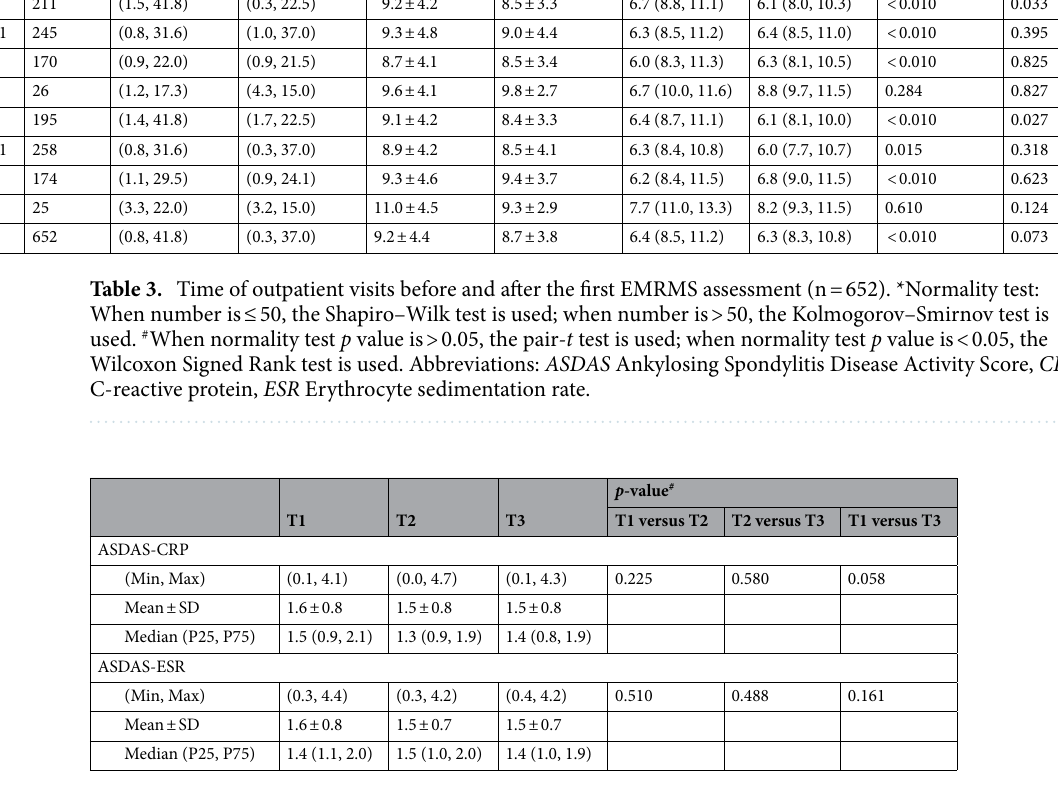
Table 4. ASDAS-CRP and ASDAS-ESR from three consecutive assessments † (n = 201). Abbreviations: ASDAS Ankylosing Spondylitis Disease Activity Score, CRP C-reactive protein, ESR erythrocyte sedimentation rate, T time, SD standard deviation, P percentile. † Comorbidities were identified within 1 year before the index date. # Because the p -value of the normality test (Kolmogorov–Smirnov test) is < 0.05, the Wilcoxon Signed Rank test is used. † Time of the three consecutive assessment: T1: the earliest time was considered the first time; T2: the second time was 84 ± 7 days; T3: the third time was 168 ± 7